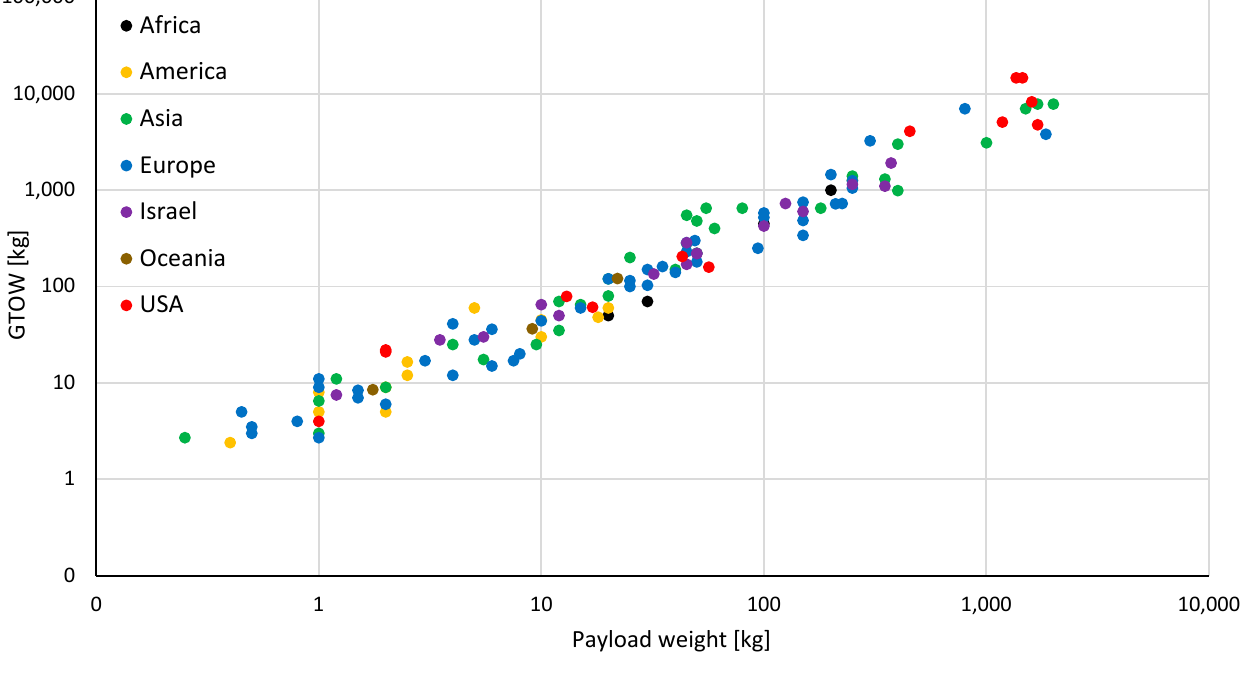
Figure 10. GTOW as a function of payload weight with respect to region of origin. Figure 11 shows the data scatter for the empty weight parameter as a function of GTOW, and Figure 12 shows the same distribution with respect to NATO classification. Table 7 sums up the statistical data regarding the trend fitting for the empty weight as a function of GTOW plots. In this case, the level of confidence for the trendlines is higher, as no R 2 is calculated below 0.75 for any NATO category. However, note that this chart shows the W e and not the empty weight ratio ( W e / W 0 ) employed by most design textbooks. Figure 13 shows the empty weight parameter against GTOW per region of origin. As is the case with Figure 11, no major deviations are observed from the main trend for any of the regions.